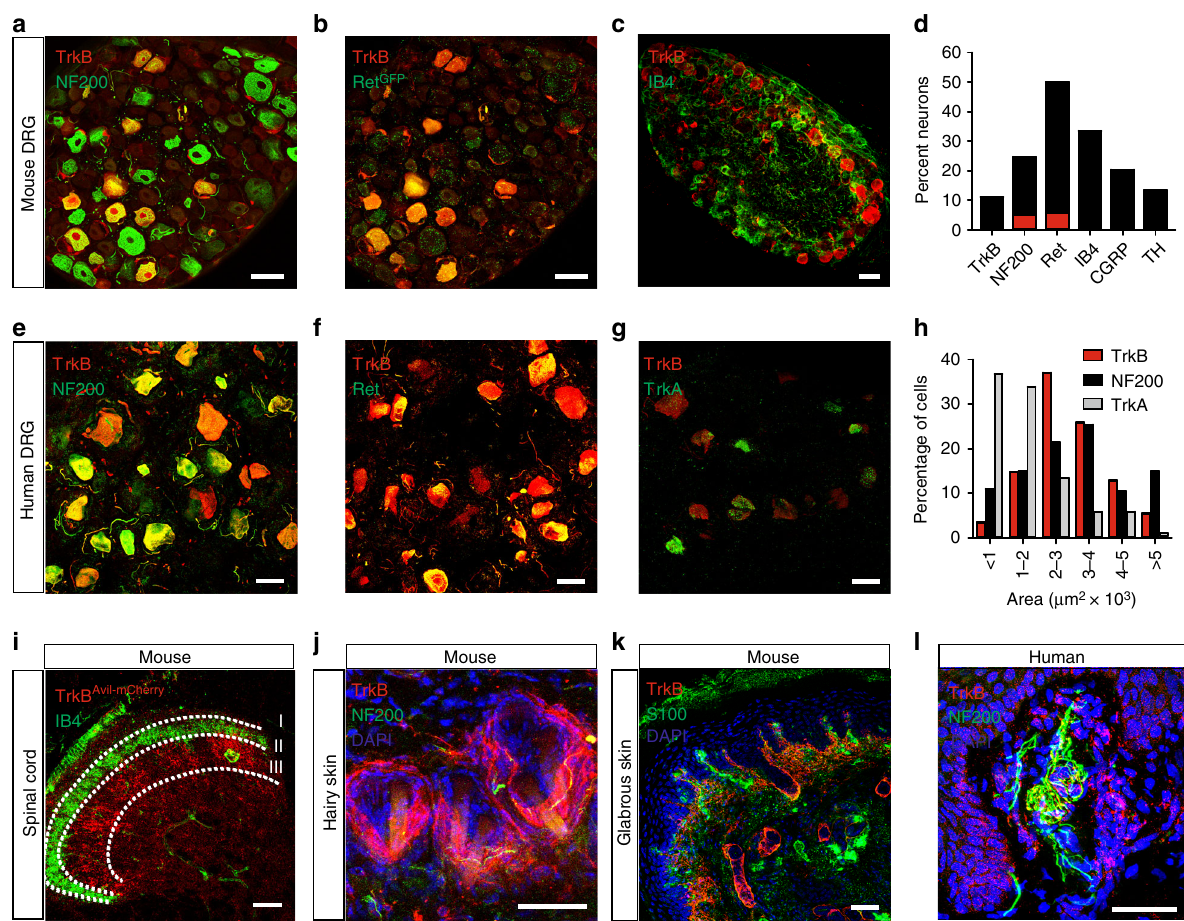
Fig. 1 TrkB-positive sensory neurons are putative mechanoreceptors. a – d Double immuno fl uorescence of DRG sections from TrkB CreERT2 ::Rosa26 RFP mice with a NF200, b Ret, visualized using TrkB CreERT2 ::Rosa26 RFP ::Ret EGFP triple transgenic mice, c IB4, d quanti fi cation of staining on mouse DRG sections; TrkB + cells account for ~10% of all DRG neurons and all co-express NF200 or NF200 + Ret eGFP , while they are negative for IB4, CGRP, and TH. e – h Double immuno fl uorescence of human DRG sections stained with antibodies against TrkB and e NF200, f Ret, g TrkA. h Size distribution for human DRG neurons expressing TrkB, NF200, and TrkA. i Section through the lumbar spinal cord of TrkB CreERT2 ::Avil mCherry mice stained with IB4. j TrkB + lanceolate endings in a section of the back hairy skin of TrkB CreERT2 ::Rosa26 SnapCaaX labeled with Snap Cell TMRstar (red), NF200 (green), and DAPI (blue). k Section from the glabrous skin of TrkB CreERT2 ::Rosa26 ChR2YFP (red) stained with anti-S100 a marker for Meissner ’ s corpuscles (green) and DAPI (blue) showing TrkB + innervation. l Section from human glabrous skin stained with antibodies against TrkB (red) and NF200 (green), and DAPI (blue). Scale bars, a – c and i 50 μ m, e – g and j – l 40 μ